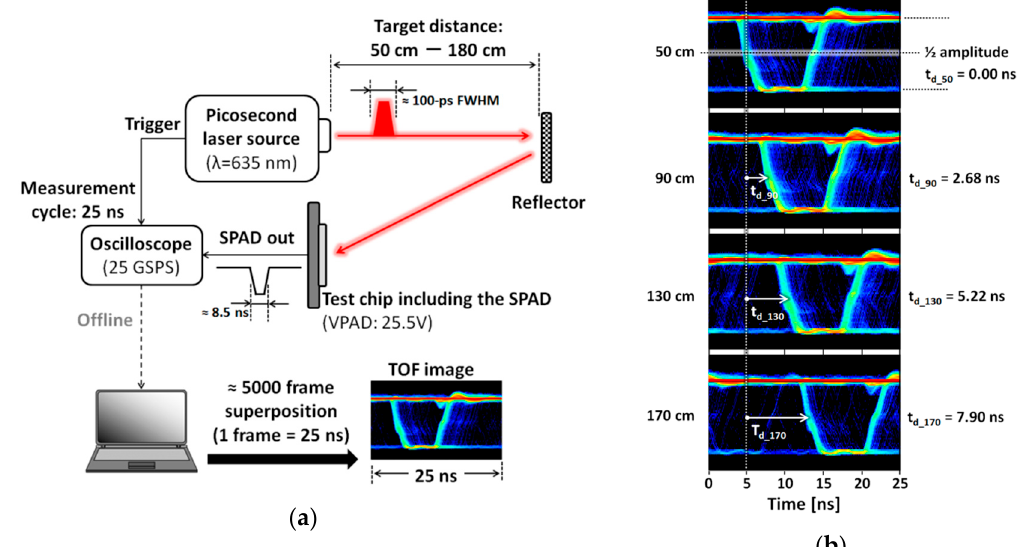
Figure 8. ( a ) Measurement system for the TOF and target distances; ( b ) TOF images superimposing 5000-frame SPAD out signals at 50, 90, 130, and 170 cm. From the TOF images, each delay time ( t d ) over various distances is measured, based on the result at 50 cm.